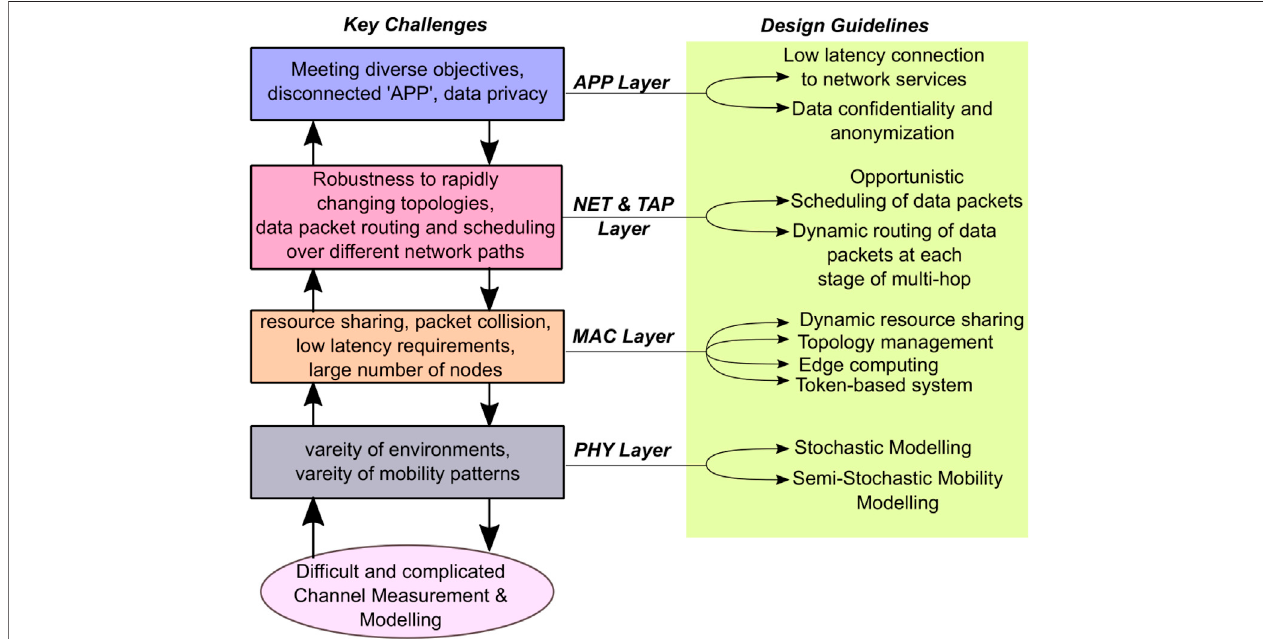
FIGURE 4 | Design guidelines for the proposed end-to-end IoT-based architecture.